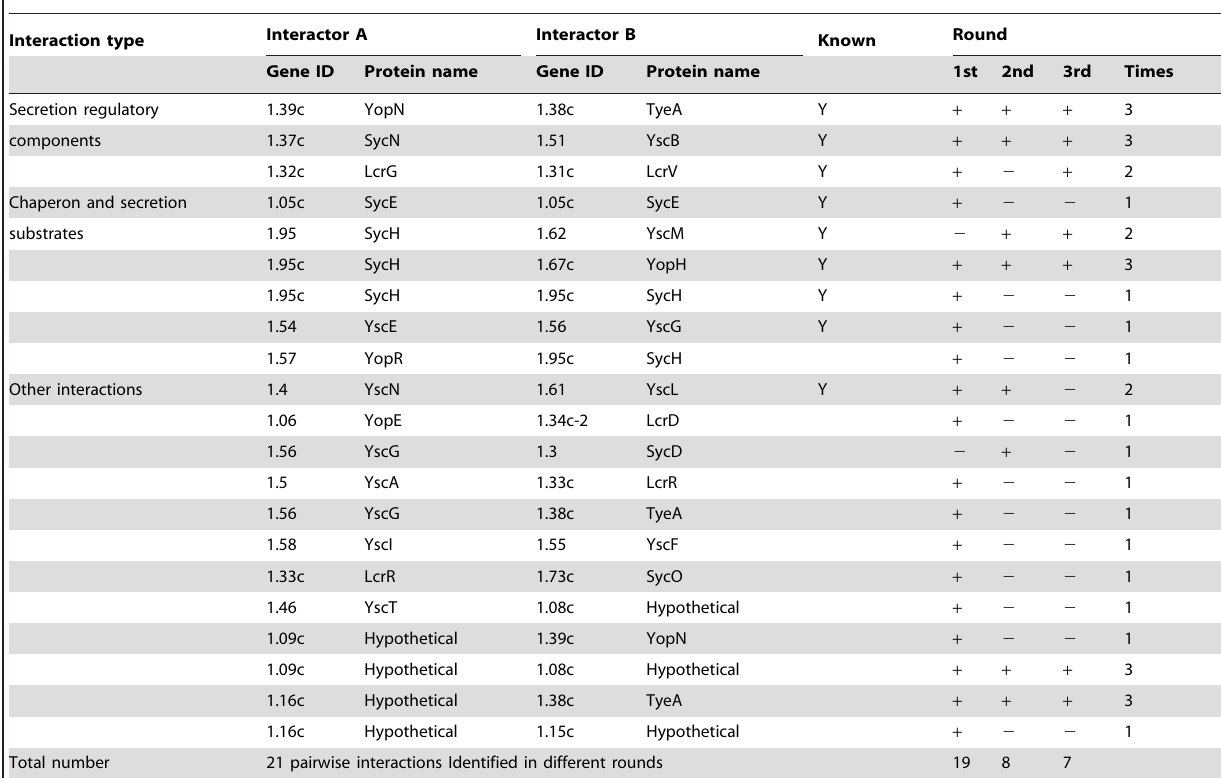
Table 1. Protein-protein interactions of the Y. pestis TTSS measured byY2H.